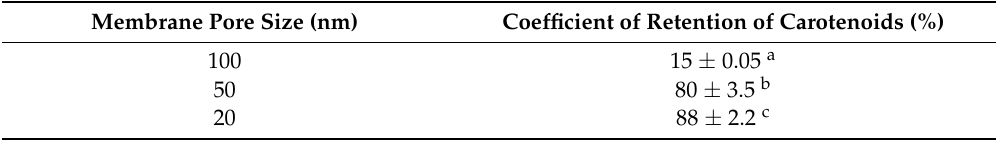
Table 6. Effect of TMP on coefficient of retention of total carotenoids content (TCC) in retentate. Transmembrane Pressure (bar) Coefficient of Retention of Carotenoids (%)